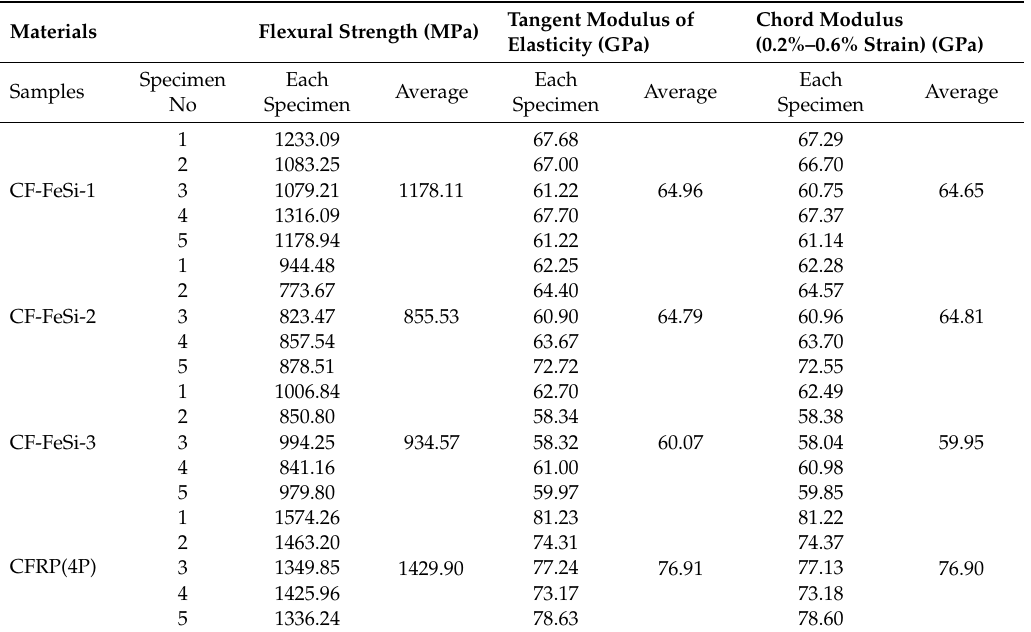
Figure 7. Flexural stress–strain curves CFRP-FeSi soft magnetic composites: ( a ) CF-FeSi-1; ( b ) CF-FeSi-2; ( c ) CF-FeSi-3; ( d ) CFRP (four-ply). Table 5. Basic flexural properties of the CFRP-FeSi composites.